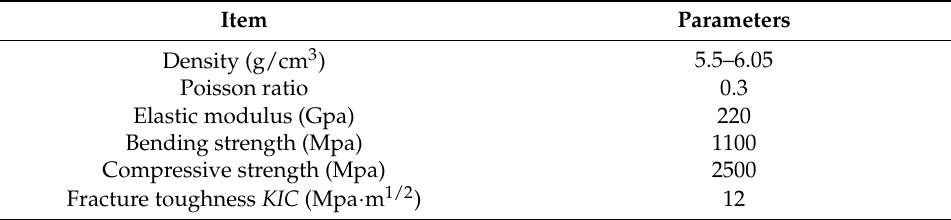
Table 3. Performance parameters of Nano-ZrO 2